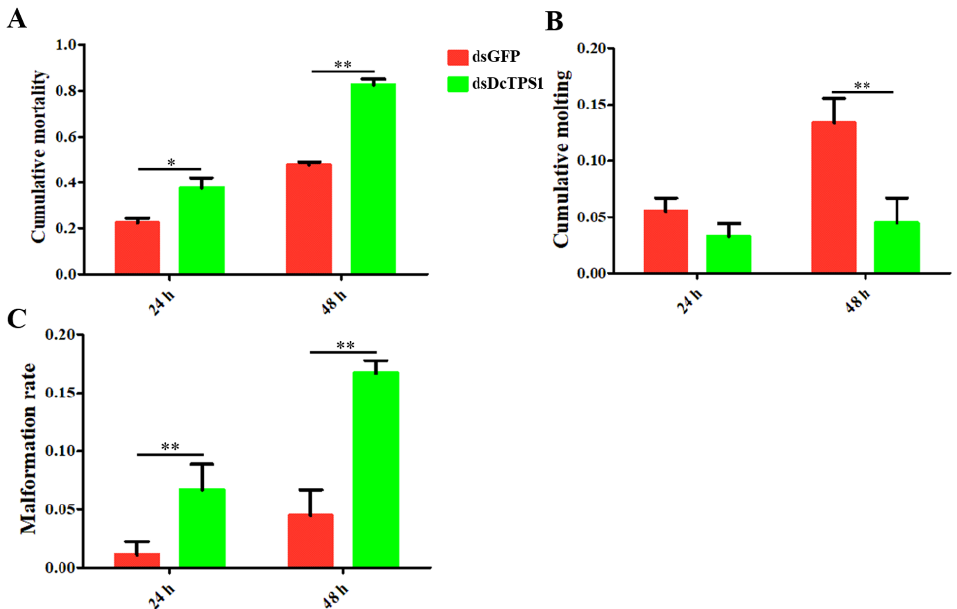
Figure 5. Statistical analysis of D. citri mortality, malformation and molting after inhibition of DcTPS1 . ( A ) Determination of D. citri mortality after inhibition of DcTPS1 . The ds GFP treatment group was used as a control; ( B ) Detection of malformation rate of D. citri at 24 h and 48 h after RNAi of DcTPS1 ; ( C ) Detection of cumulative molting of D. citri at 24 h and 48 h after inhibition of DcTPS1 . The asterisks indicate the significance differences by * p < 0.05 and ** p < 0.01. The SPSS software was used to conduct statistical analysis.